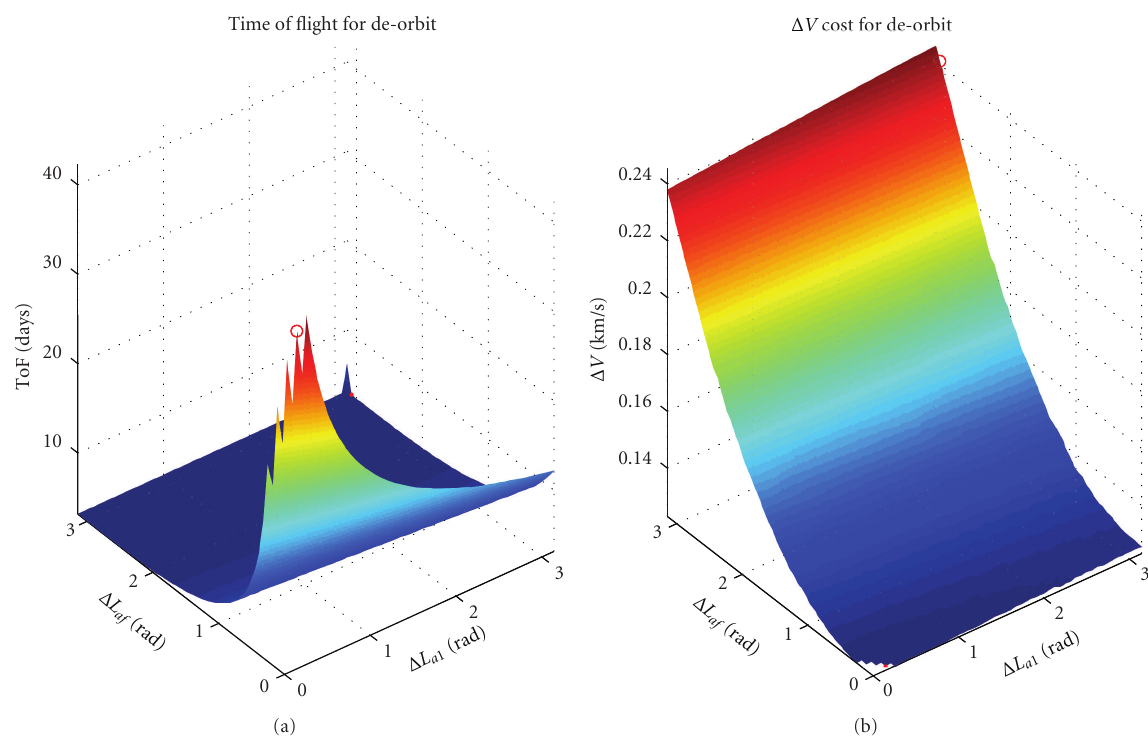
Figure 3: (a) Δ V and (b) TOF surfaces with respect to Δ L a 1 and Δ L af for m IBS0 = 300 kg, a debr0 = 7128 km and m debr = 120 kg.